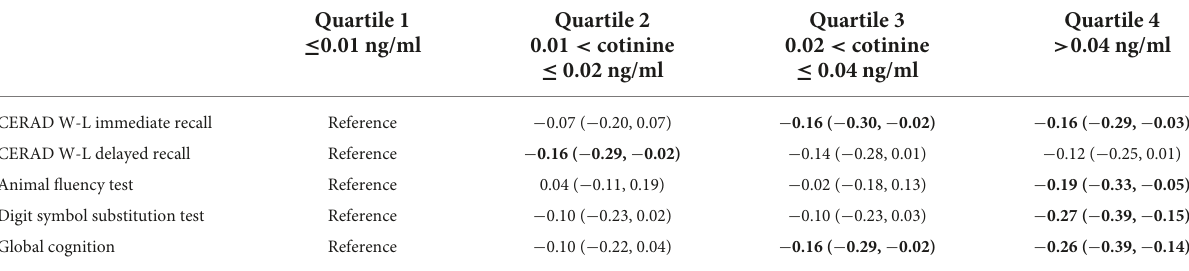
TABLE 3 The associations of quartile of serum cotinine level (Reference: ≤ 0.01 ng/ml) with test specific and global cognition z scores a